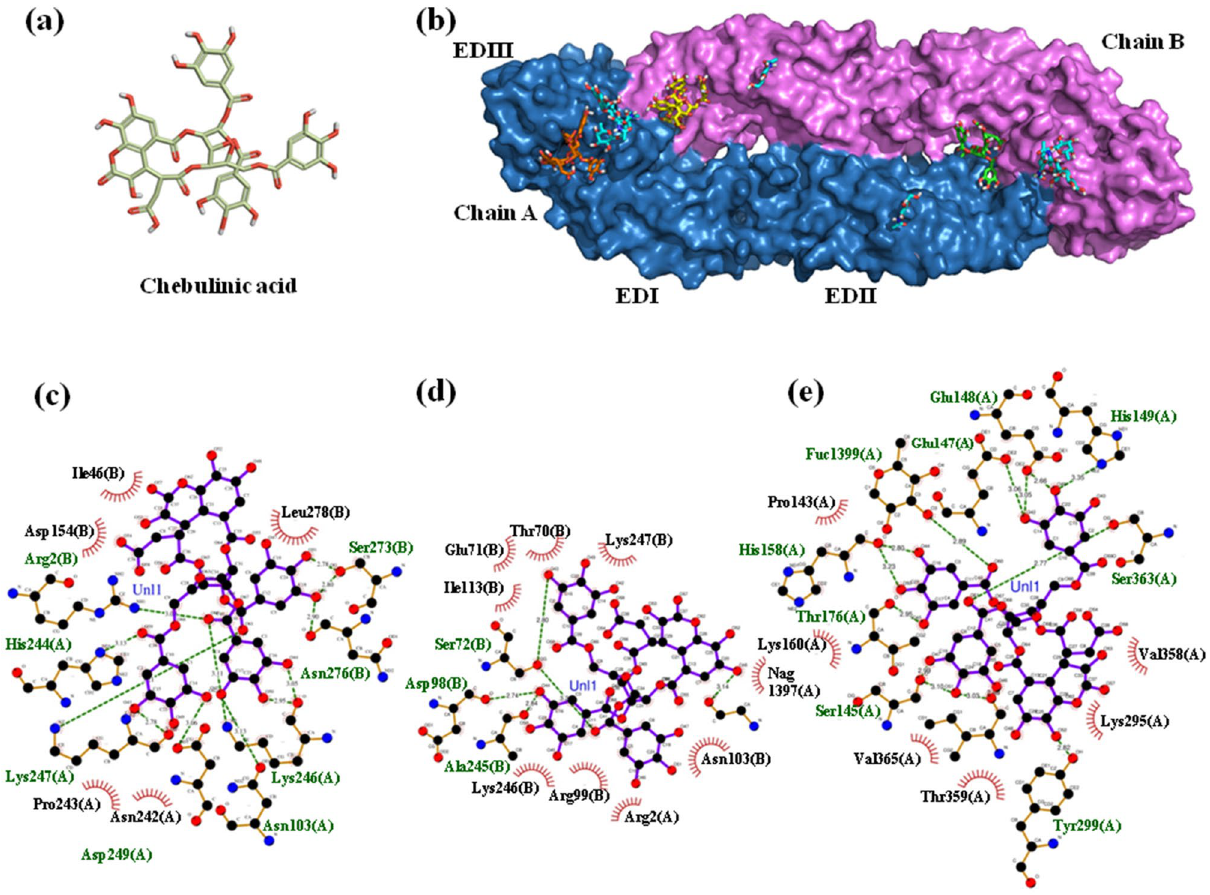
Figure 5. Structural depiction of chebulinic acid, DENV E protein homodimer, and their docked conformations. ( a ) Two-dimensional structure of chebulinic acid (CA), wherein the carbon, oxygen, and hydrogen atoms are depicted in olive green, red, and white colors, respectively. ( b ) Surface diagram of DENV E homodimer with docked conformations of CA molecules. The backbone of the homodimer chains A and B are represented in blue and pink colors, respectively. The glycans on the surface of E protein are represented in sticks with carbon backbone depicted in cyan color. The CA molecules docked at Kl β-hairpin loop, fusion peptide, and EDIII-EDI pockets are shown in sticks with green, yellow, and orange carbon color schemes. The oxygen and hydrogen atoms of the CA are depicted in red and white colors, respectively. This diagram has been prepared using the molecular visualization system PyMOL 47 . Schematic depiction of DENV E-CA interactions at ( c ) Kl β-hairpin loop pocket, ( d ) fusion peptide pocket, ( e ) EDIII-EDI pocket that is mediated by hydrogen bonds (dashed green lines) and by hydrophobic contacts (red arcs with spokes). These diagrams are generated by the LigPlot software 45,46